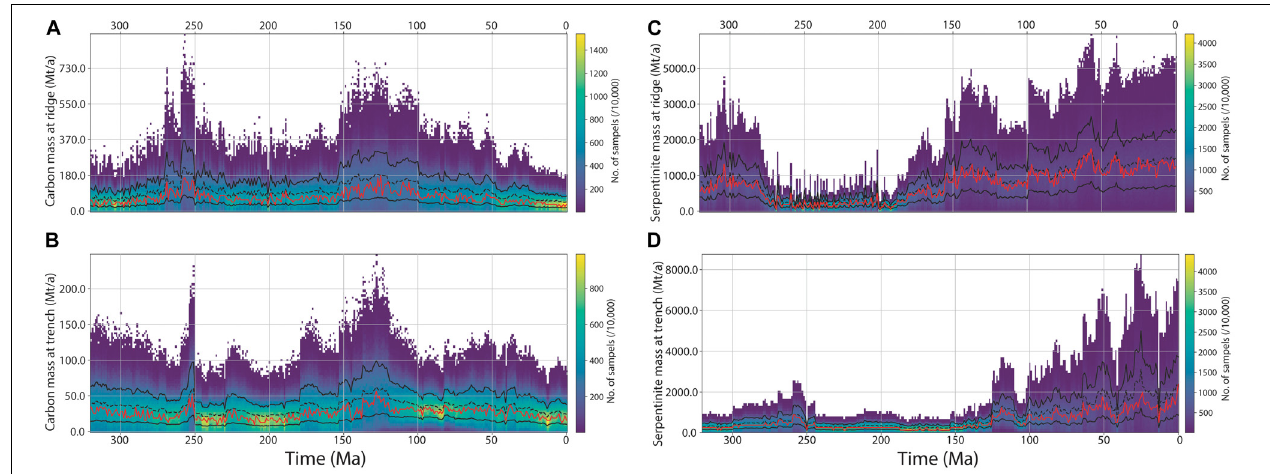
FIGURE 7 | Distributions (10000 samples) of (A) mass of carbon sequestrated at mid-ocean ridges, (B) mass of carbon entering a subduction zone, (C) mass of serpentinite formation at mid-ocean ridges, and (D) mass of serpentinite entering a subduction zone. Red line is mode of samples, dashed black line is mean ( ∼ , to mode for C ), and solid black lines show 1 standard deviation from the mean. The carbon distribution is skewed to the right.